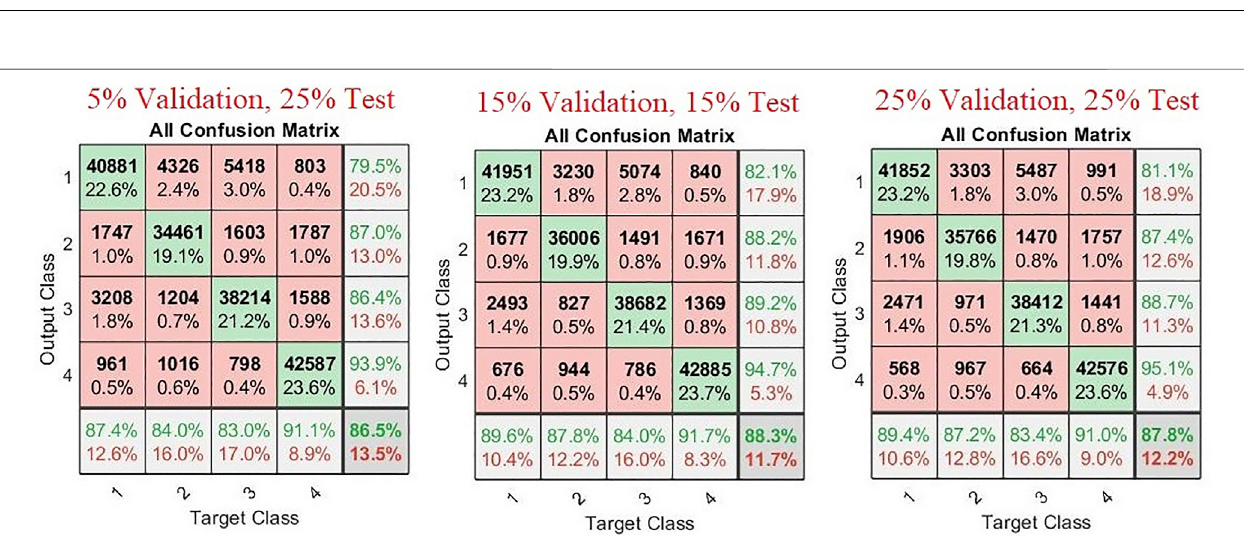
FIGURE 4 | Confusion matrices with rising and whole curve along with 1,000 and 4,000 hidden neurons.